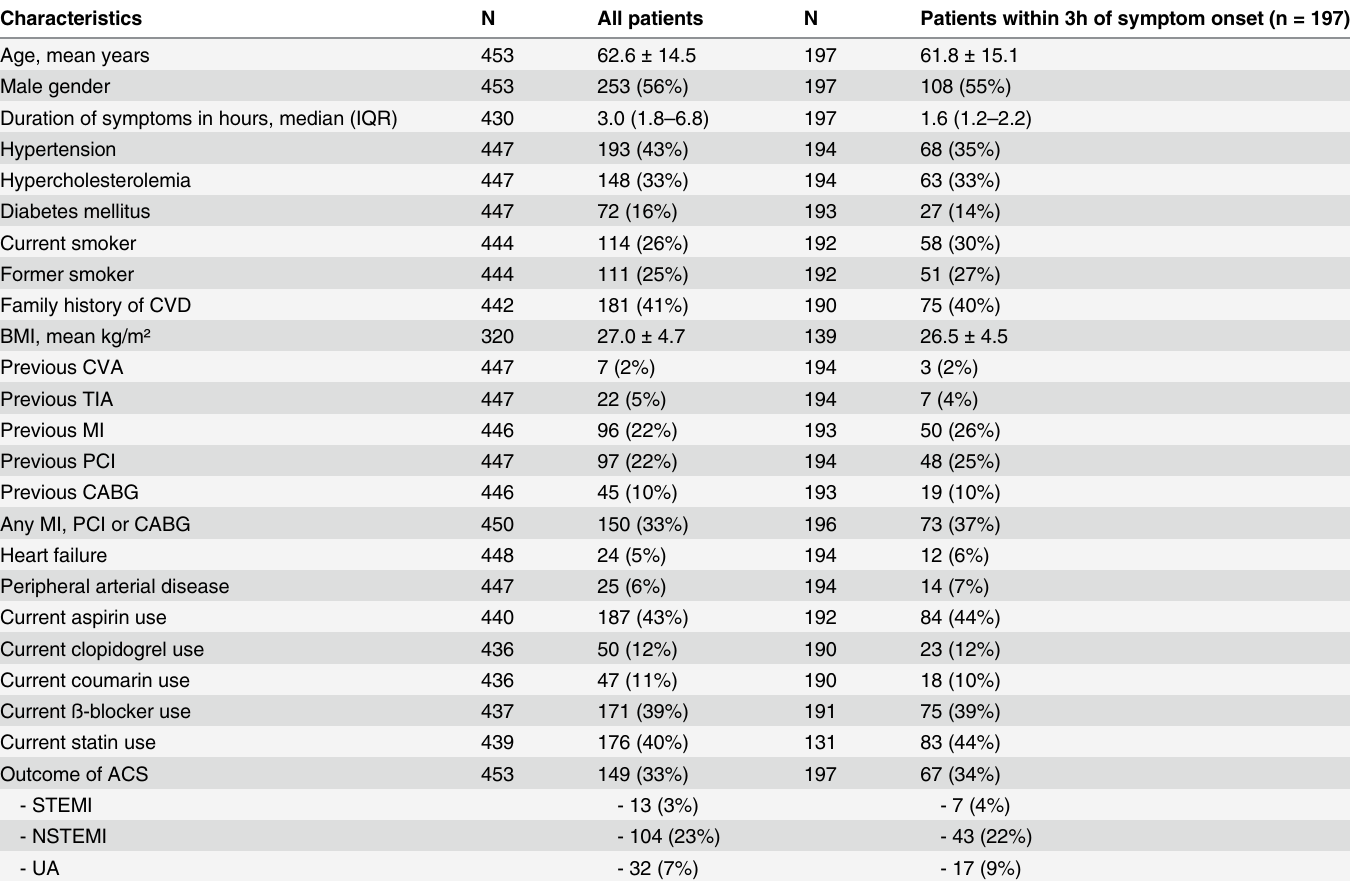
Table 1. Baseline characteristics stratified by time of presentation after symptom